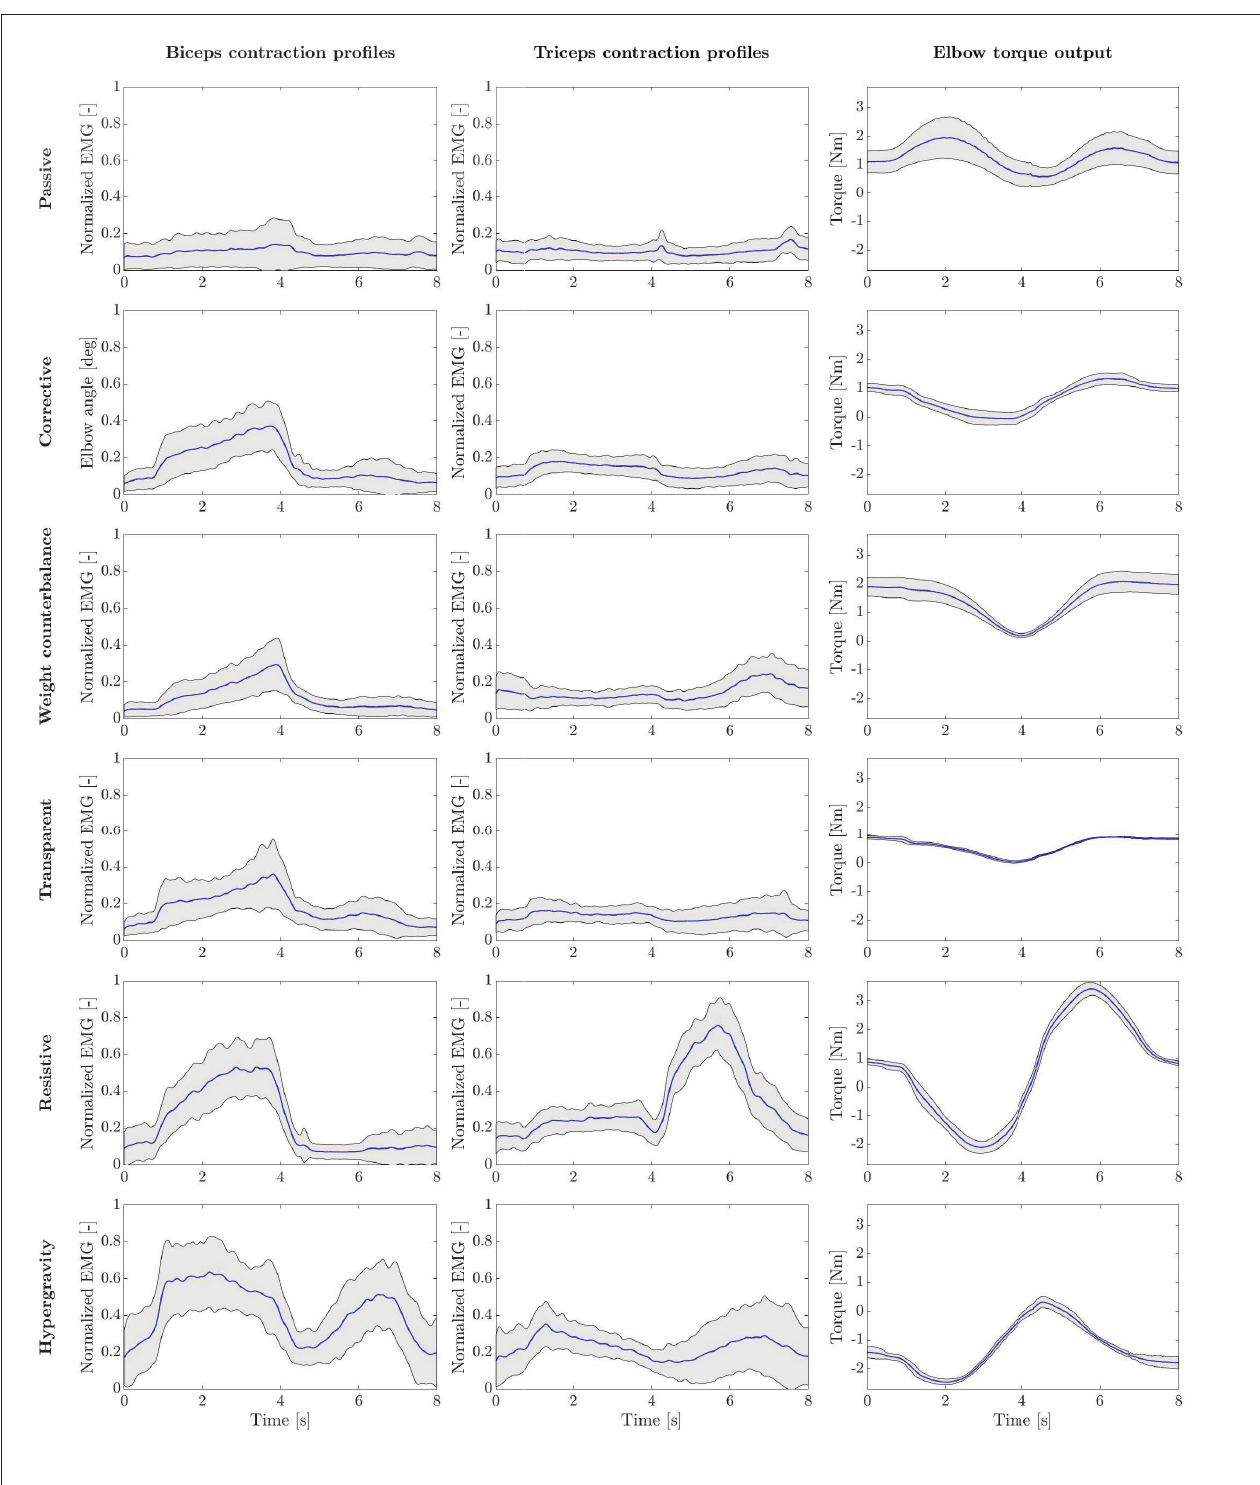
FIGURE 10 | Experimental results for all the presented rehabilitation modalities. Each row represents a different mode. Subplots show biceps and triceps normalized EMG, and measured interaction torque, generated at the output joint axis. Bold blue lines represent mean values, while gray areas refer to SD ranges.